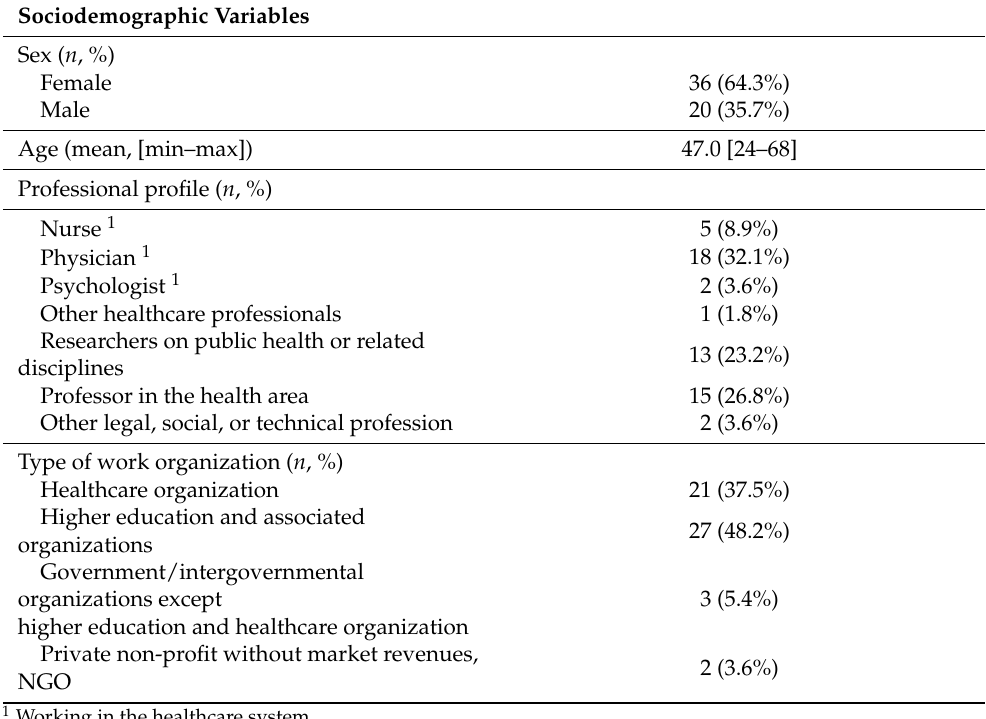
Table 1. Characteristics of the respondents ( n = 56).